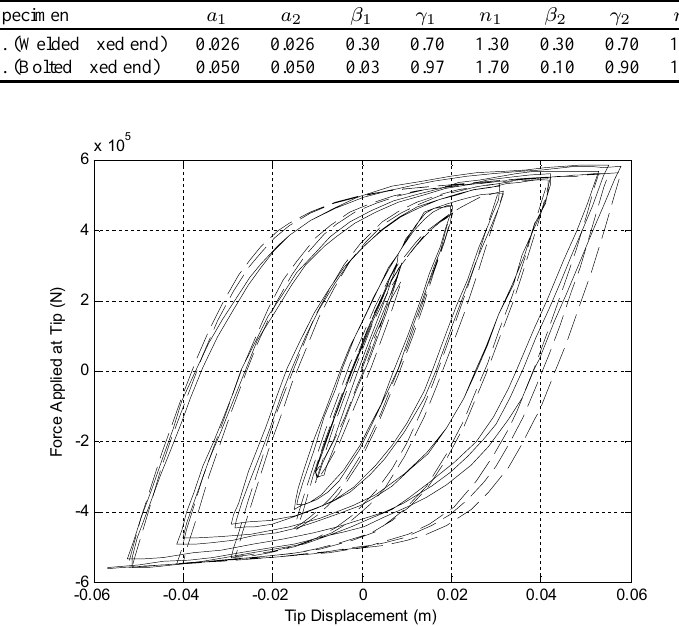
Fig. 3. Comparison between simulated (--) and experimental (–) data, Specimen 1. (Welded Fixed End)